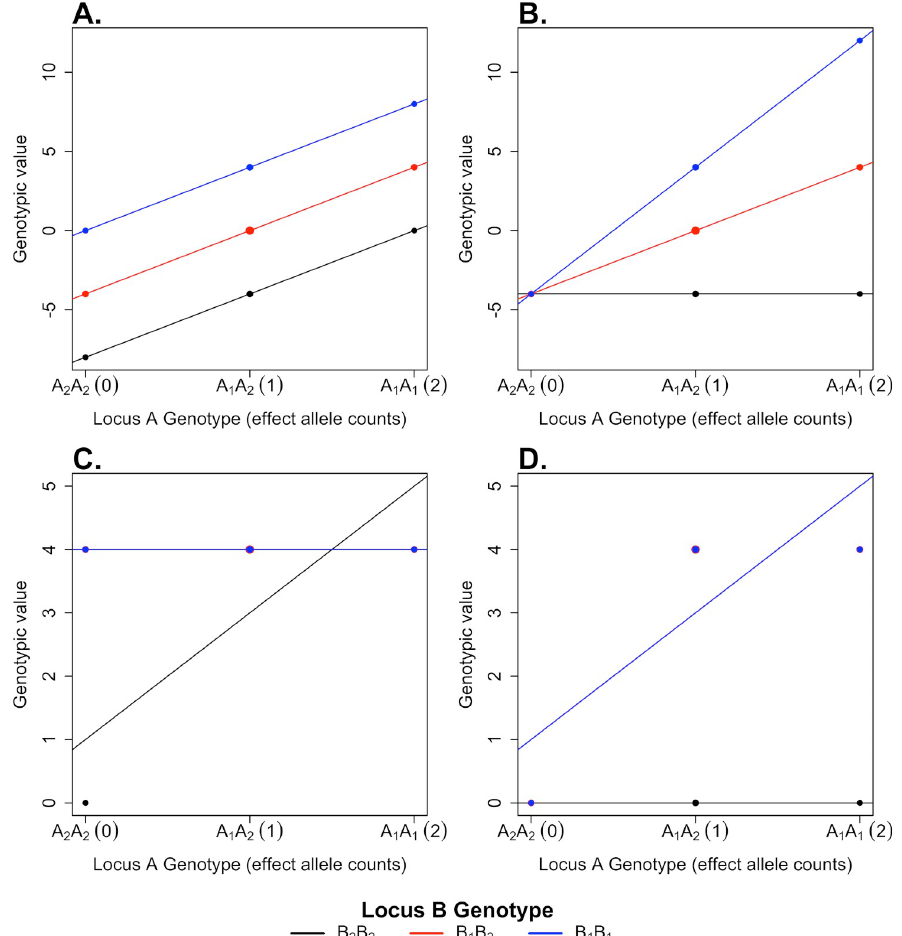
Fig 2. Genotypic values (closed circles) at 2 biallelic loci A and B in 4 different 2-locus models and the weighted least squares regression fits (colored lines) for each B locus genotype against A 1 allele dosage. In (A) , we consider a 2-locus model with additive effects only at both loci ( a A = a B = 4), while in (B) , we consider a 2-locus model with additive and additive-by-additive effects ( a A = a B = a AB = 4). In (C) , we consider a 2-locus duplicate factor model ( Table 2 ), and in (D) , a 2-locus complementary model ( Table 3 ), both with c = 4. The horizontal scale shows the number of A1 alleles in the genotype. The different genotypes at locus B are depicted in different colors (black for B 2 B 2 , red for B 1 B 2 , and blue for B 1 B 1 ). We chose allele frequencies p = q = 0.5 in all 4 models. Each point size is weighted by its genotype frequency, and linear regression lines between the number of A 1 allele and the genotypic values are fitted by weighted least squares for each locus B genotype background. In panels (C) and (D), the red and blue lines are overlaid.